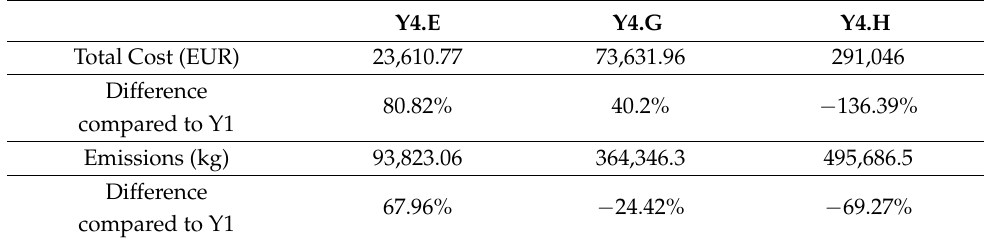
Table 7. The results for the yearly analysis Y4 and a comparison to the Y1